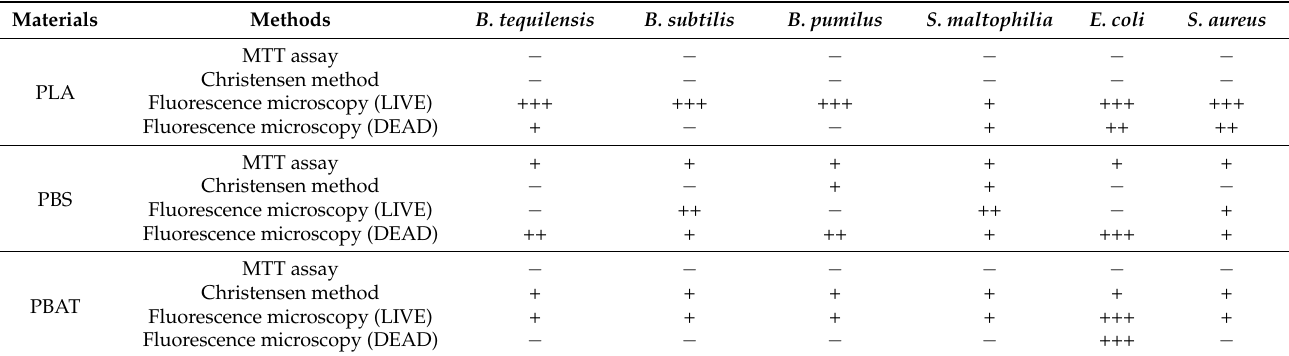
Table 2. Comparison of methods for evaluating biofilm formation for pure